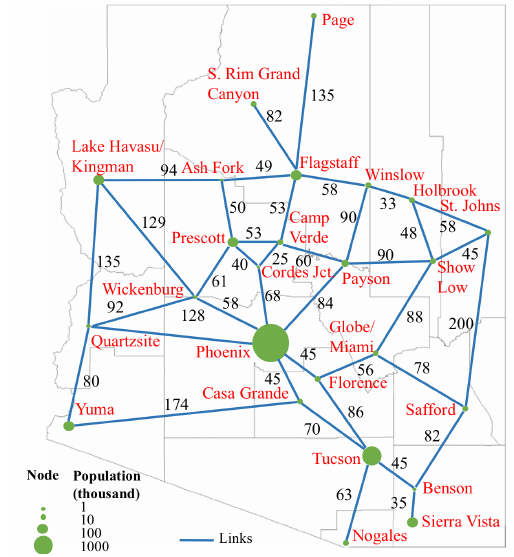
Figure 3. Arizona highway network